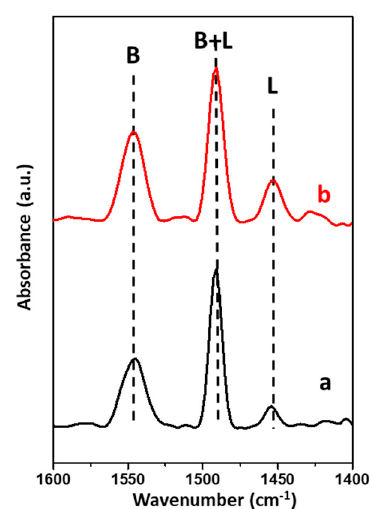
Figure 4. FTIR spectra of pyridine adsorbed on: ( a ) the bare Beta, and ( b ) the 0.4 wt% Sn-Beta at 150 °C representing in the adsorption region of Brønsted and Lewis acid sites.